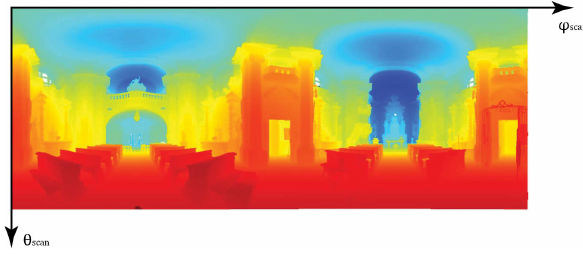
Figure 1. Range image in scanner local spherical coordinate sys.